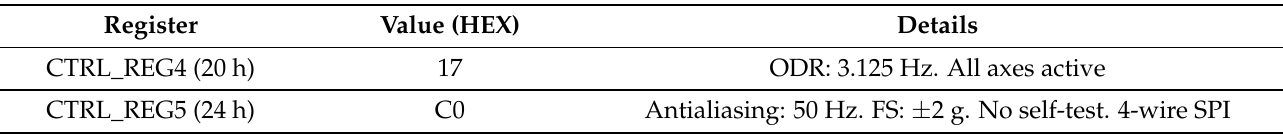
Table 2. Configuration of the studied units.